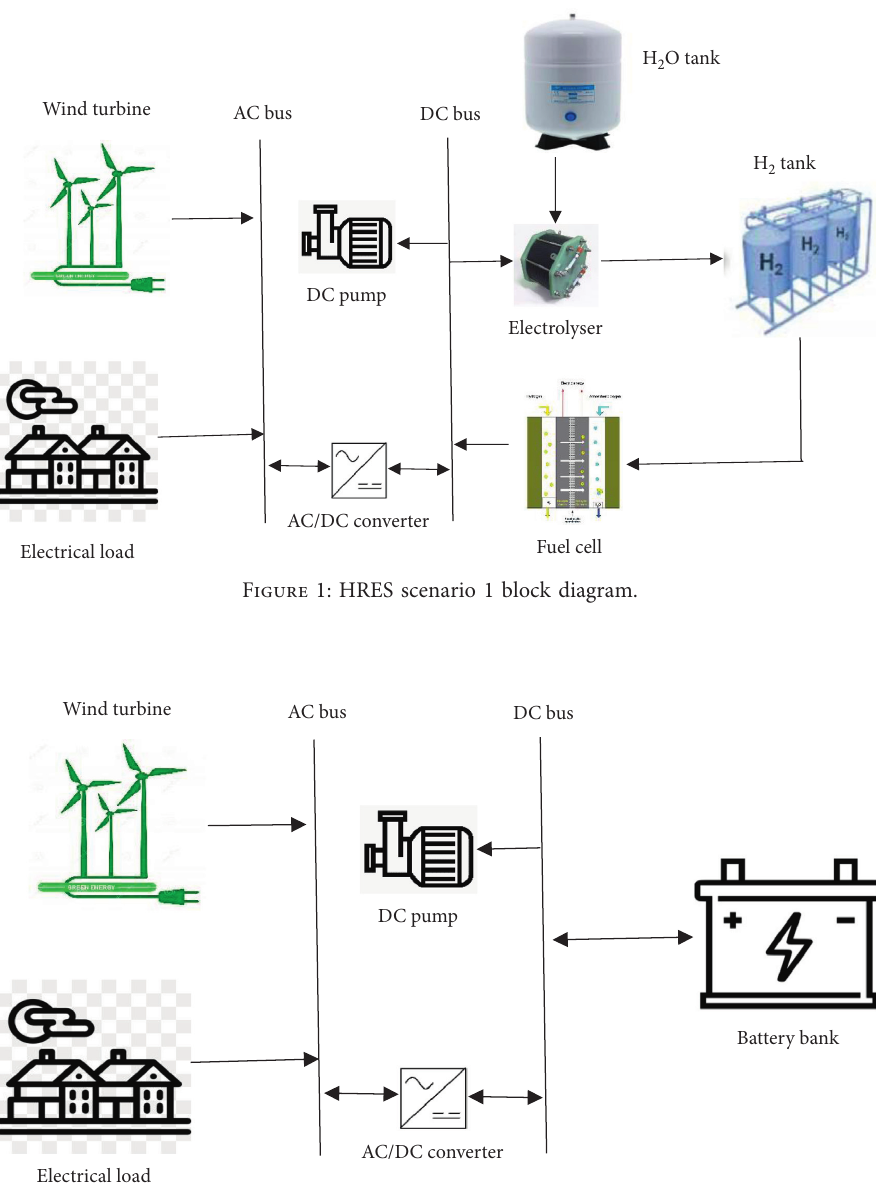
Figure 2: HRES scenario 2 block